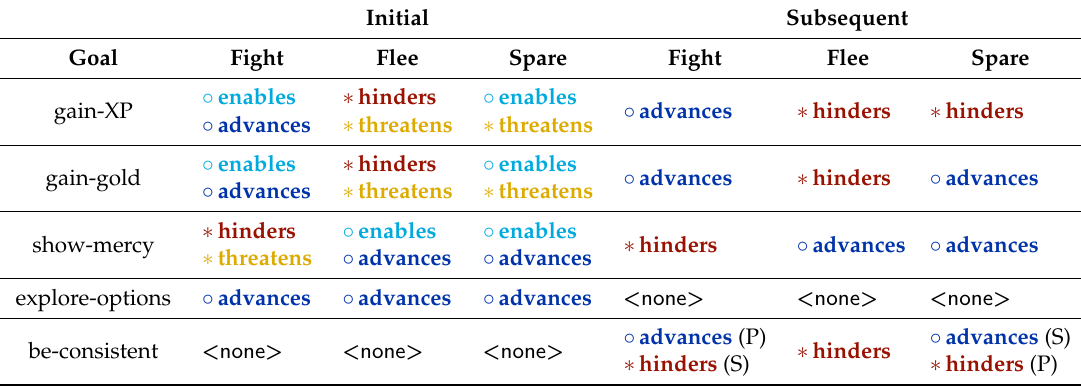
Table 2. Option analysis for the example choice shown in Figure 1. The results for initial and subsequent encounters are shown separately in the left and right halves of the table. All of the labels apply to both of our player models, except the be-consistent labels for the subsequent analysis, where the power (P) and story (S) player models each view either “fight” or “spare” as consistent and the other options as inconsistent (elsewhere stacked labels indicate that multiple labels apply for both